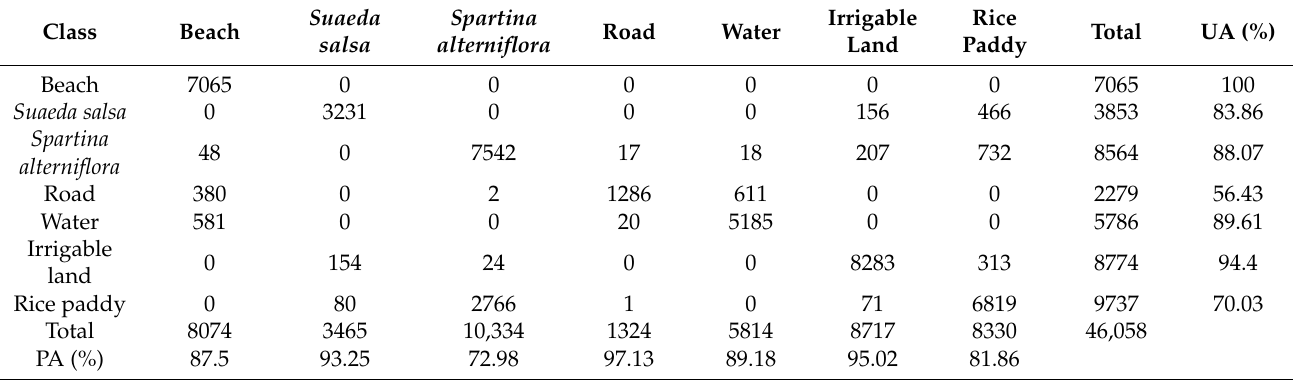
Table 9. Confusion matrix of the classification results from the ALL features set using